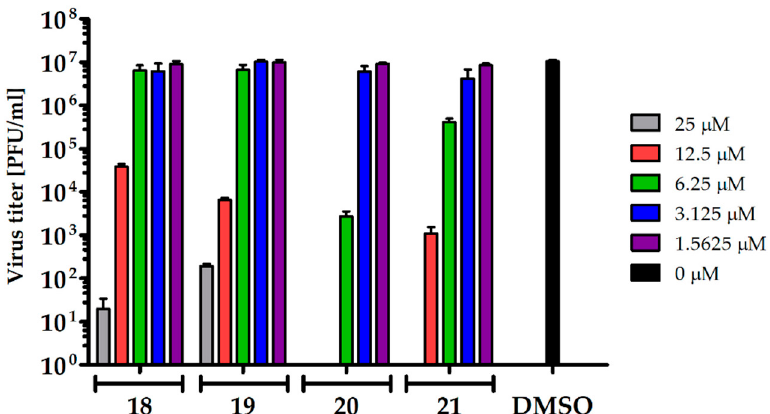
Figure 5. The effect of uridine glycoconjugates 18 , 19 , 20 and 21 on TBEV titers. A549 cells were infected with the TBEV Neudoerfl strain at an MOI of 0.1 and treated with various doses of tested compounds (0–25 μ M). At 72 h p.i., culture supernatants were collected to determine TBEV titers by plaque assay. Error bars represent standard deviations from 3 separate experiments.